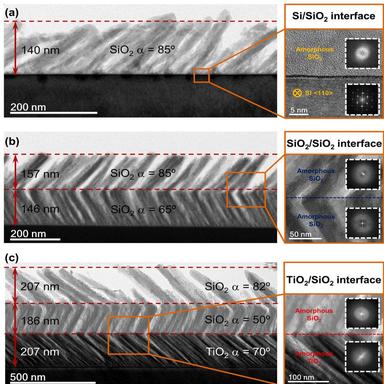
Bright-field TEM overview of different OAD systems deposited on silicon substrates. (a) SiO2 OAD monolayer deposited at α = 85◦. (b) SiO2 OAD bilayer deposited at α = 65◦ and α = 85◦ with azimuthal rotation between the two layers of Φ = 180◦. (c) TiO2/SiO2 OAD trilayer deposited at α (TiO2) = 70◦, α (1st SiO2) = 50◦ and α (2nd SiO2) = 82◦ with azimuthal rotation between layers of Φ = 180◦. The insets of (a), (b) and (c) detail the features of the Si/SiO2, SiO2/SiO2 and TiO2/ SiO2 interfaces respectively, to